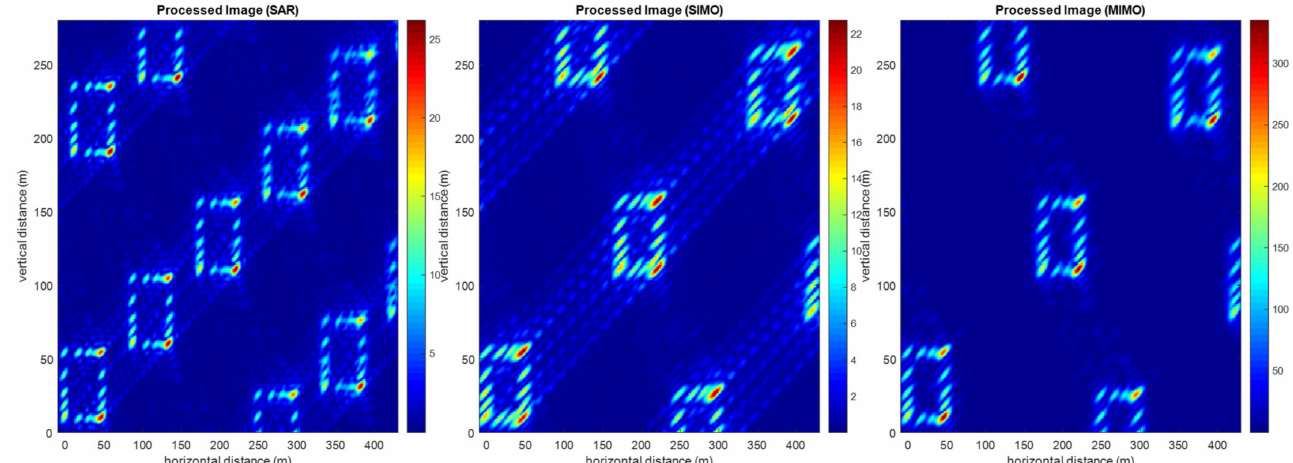
Figure 25. The simulated 2D images for Example 4 for SAR/SIMO/MIMO modes. Coarse scene resolution (1 m), large scene extent.